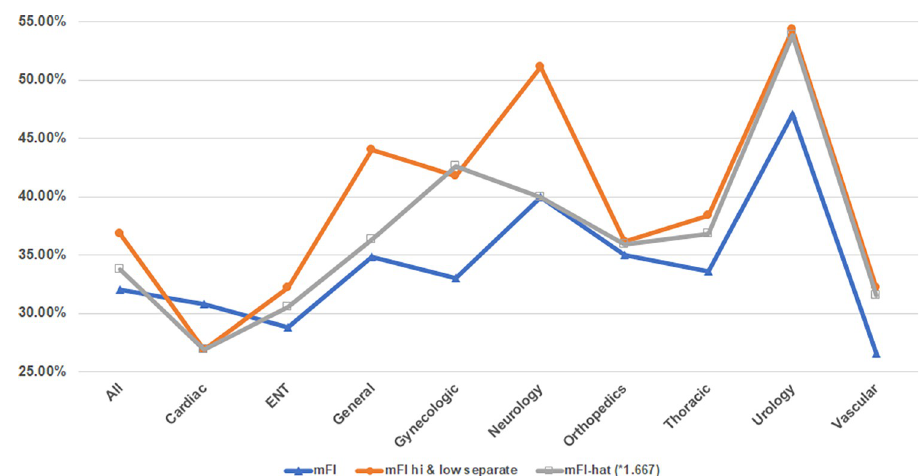
Fig 3. Comparison of ANN model’s destination prediction accuracy utilizing traditional mFI, new 2 value mFI, and ^ mFI ^